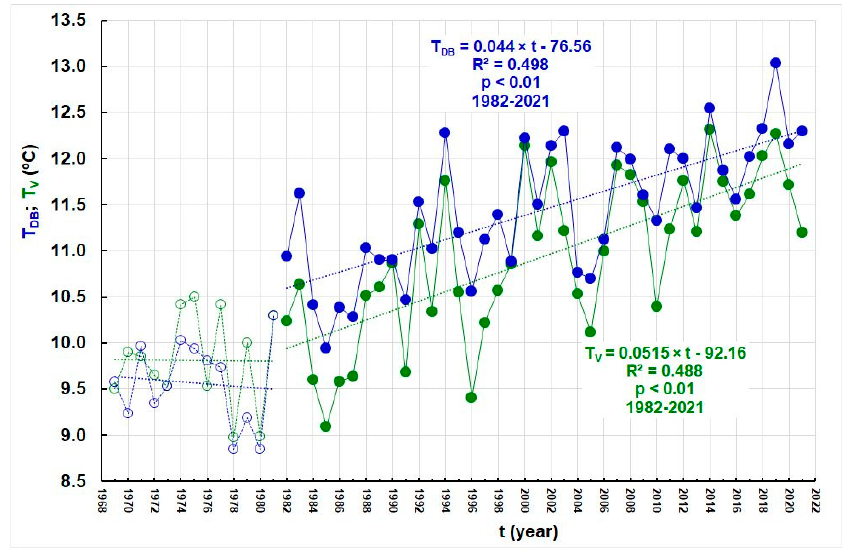
Figure 4. Two subseries of mean annual water temperatures of the Drava at the Botovo station, T DB , and air temperatures at the GMP Varaždin, T V , during the subperiods (1) 1969–1981 and (2)